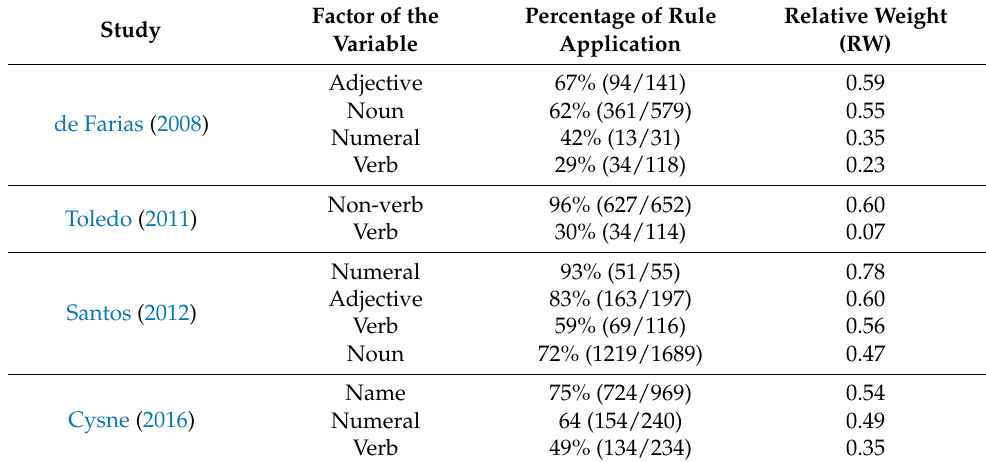
Table 7. Effects of the factors of the variable grammatical class of the